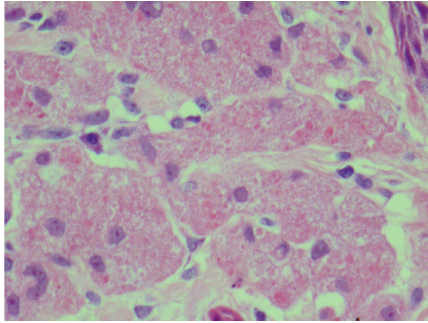
Figure 3: High power view of oral granular cell tumour stained with hematoxylin and eosin.